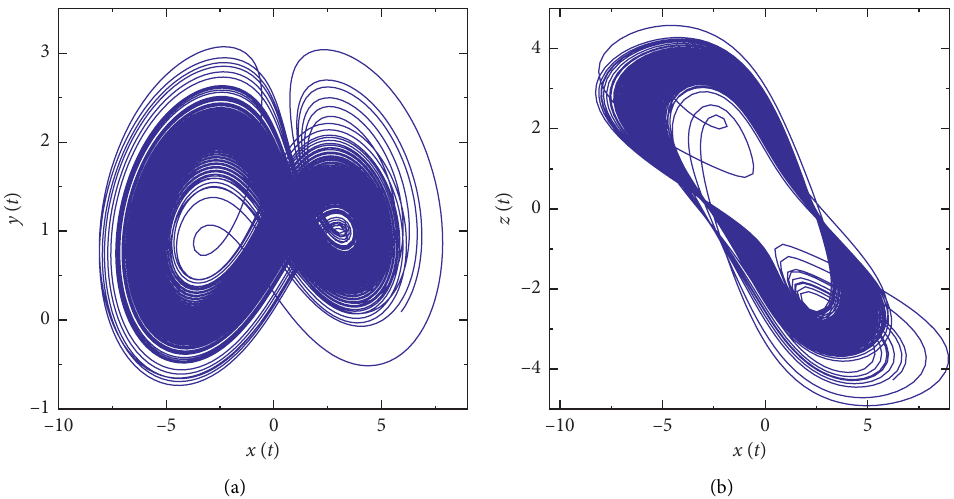
Figure 6: Phase diagrams of system (6) with fractional orders q the x − z phase plane.